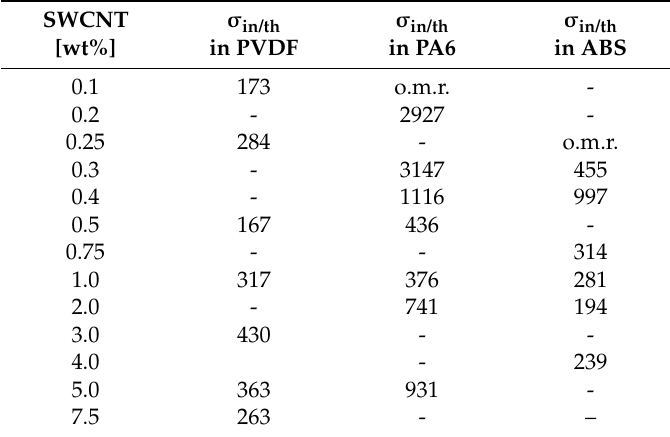
Table 3. Quotient of in-/through-plane σ values ( σ in/th ) of different matrix composites with SWCNTs, measured in two directions on compression molded plates.